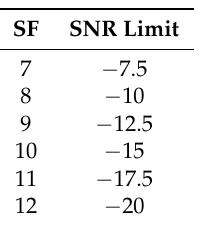
Table 3. Minimum signal-to-noise ratio (SNR) to be guaranteed for signal demodulation based on SF